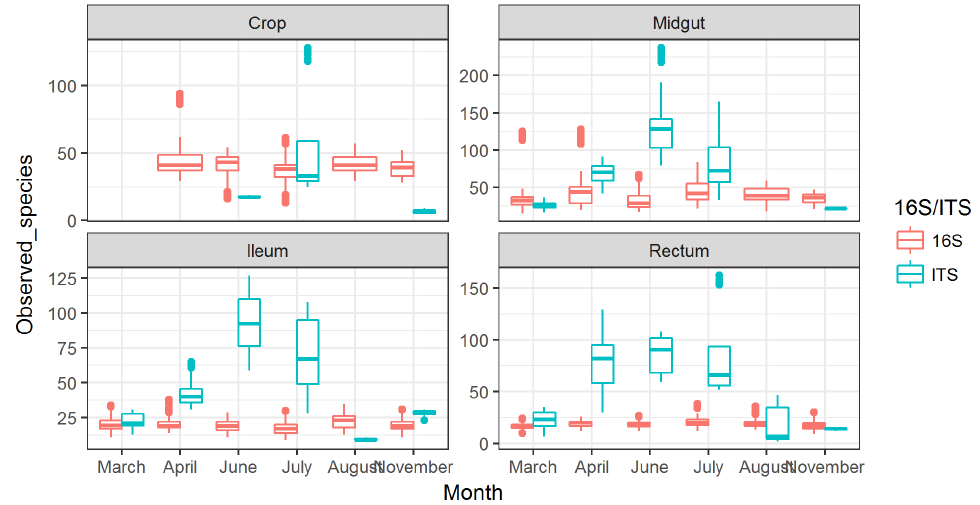
Figure 2. Observed species for bacteria (16S) and fungi (ITS) shown across months for different gut part. The missing data in the figure are due to lack of information for those datapoints. This particularly relates to fungi in crop, as the levels were very low.